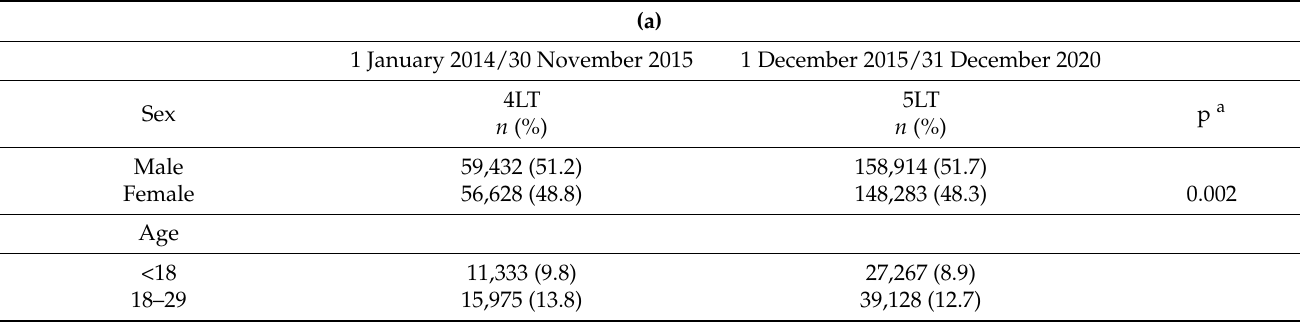
Table 1. ( a ) Principal personal and ED presentation features of patients included in the study, by period of observation. The 4LT period (T4) spanned 1 January 2014 to 30 November 2015; the 5LT period (T5) spanned 1 December 2015 to 31 December 2020. a : χ 2 test. ( b ) Pathology at admission for the patients included in the study, by period of